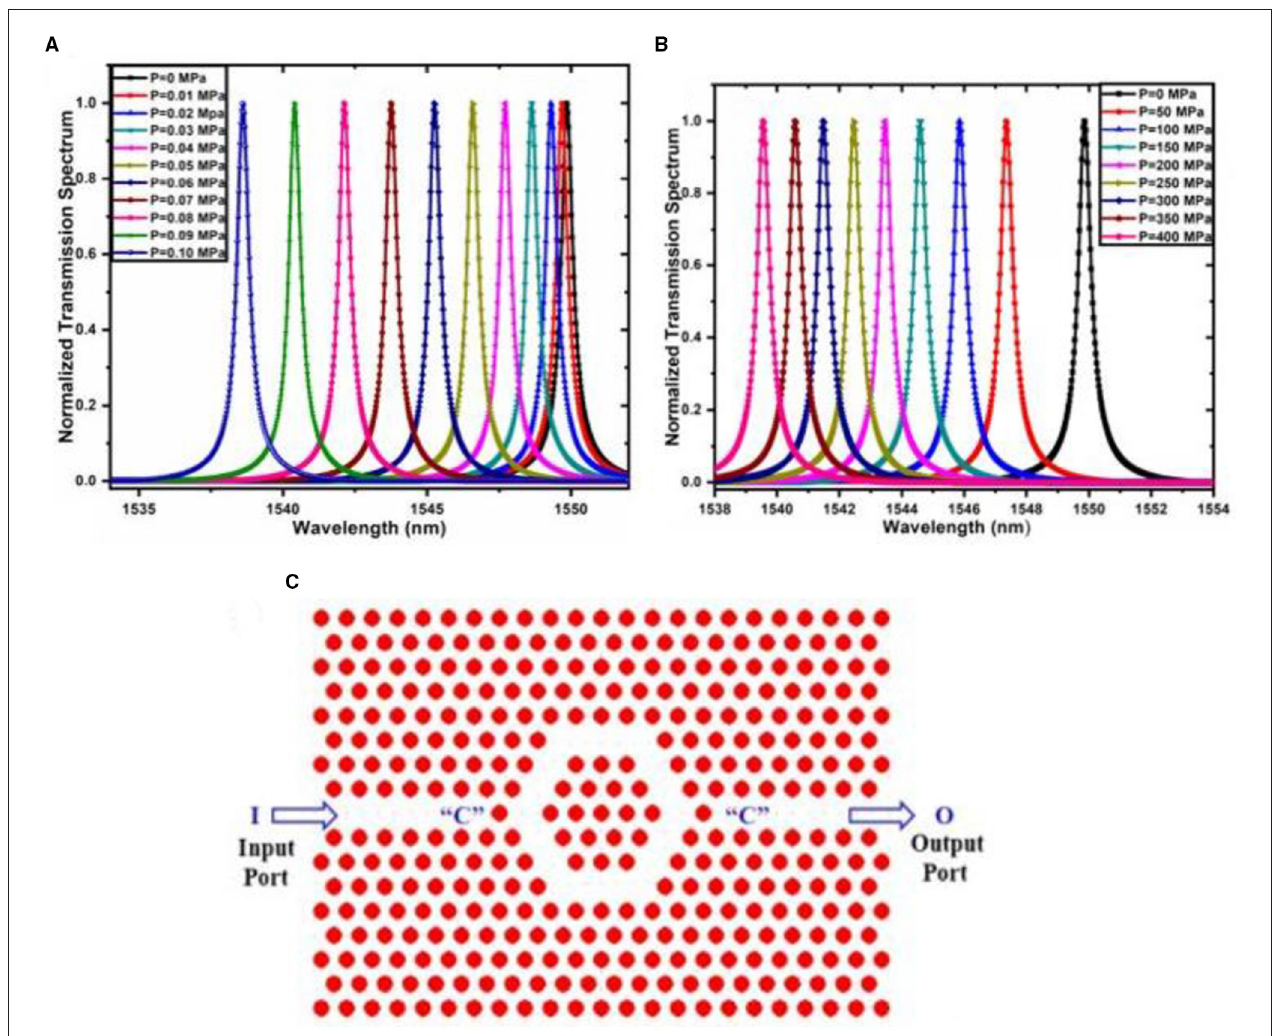
FIGURE 6 | Peak resonant wavelength for sensing structure (A) fixed at one end. (B) Fixed at both the end (35). (C) Hexagonal photonic crystal ring resonator-based pressure-temperature sensor